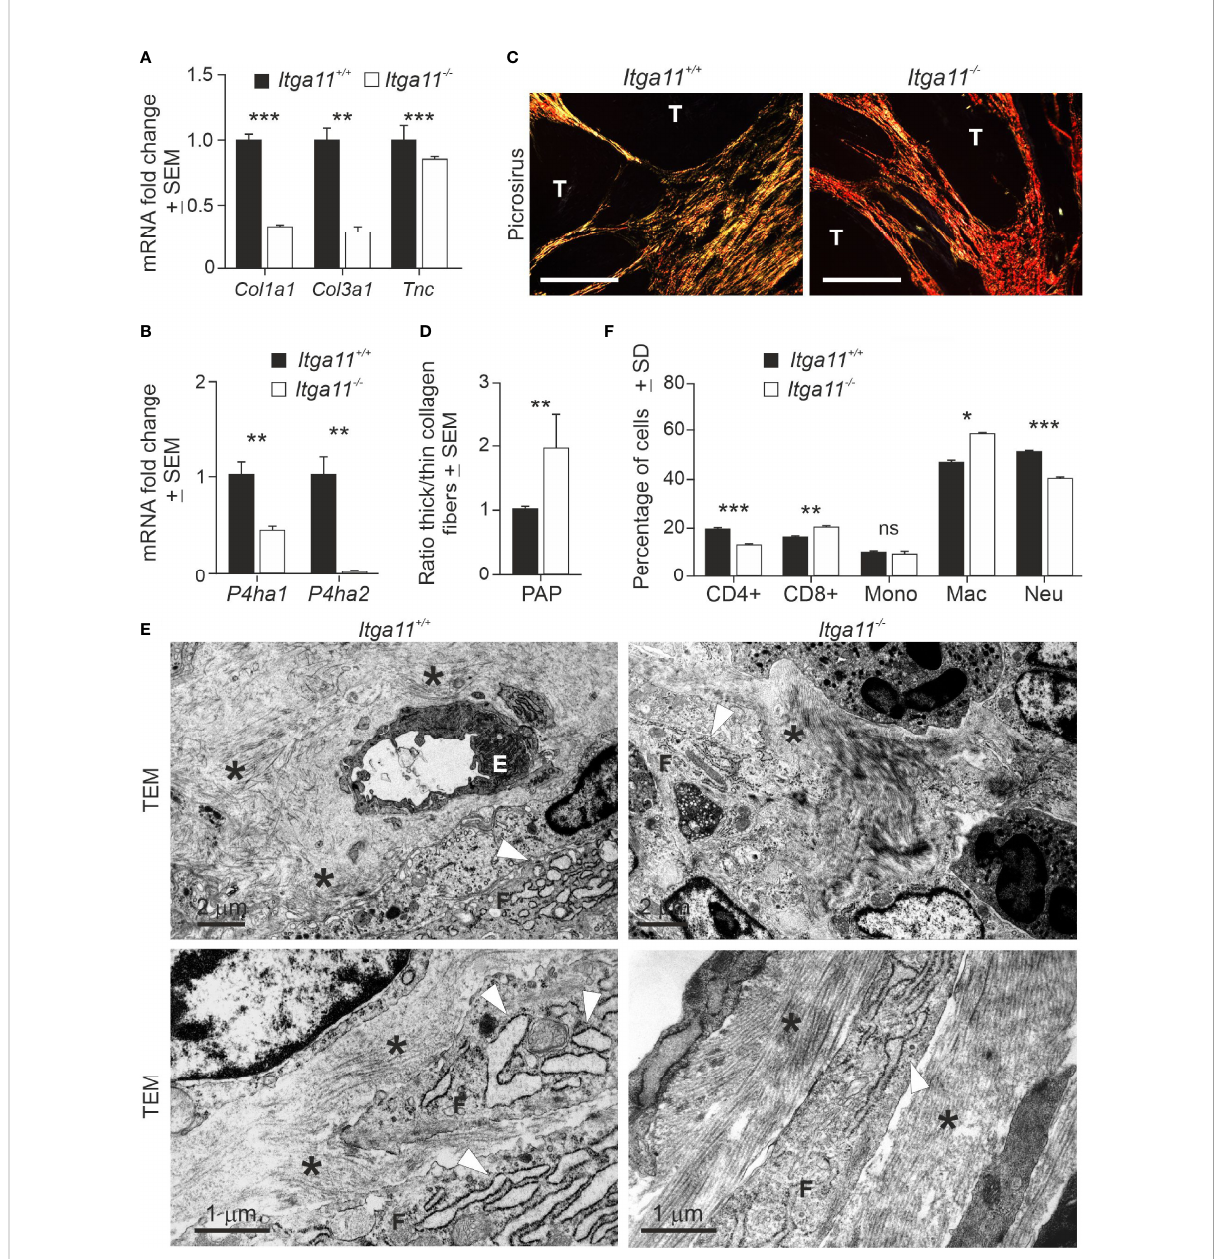
FIGURE 4 Characterization of a 11-de fi cient of skin tumor stroma. (A, B) RT-qPCR analysis of collagen I ( Col1a1 ) and III ( Col3a1 ) a 1 chain, tenascin ( Tnc ), and prolyl-4-hydoxylase 1 ( Pdha1 ) and 2 ( Pdha2 ) in Itga11 +/+ and Itga11 -/- papillomas. RT-qPCR data are an average of ten samples (from different individuals) per genotype collected at weeks 19 – 20 and normalized with endogenous Gapdh . (C) Representative images of picrosirius red staining of Itga11 +/+ and Itga11 -/- papillomas imaged by polarized light microscopy. Thin collagen fi bers appear as yellow/green, and thick collagen bundles appear as red/orange tones. Scale bar, 200 m m. T, tumor. (D) The quanti fi cation of collagen birefringence shows that the ratio of thick/thin collagen fi bers is signi fi cantly increased in the Itga11 -/- tumors compared to the Itga11 +/+ tumors (n = 10 per genotype). (E) Transmission electron microscopy (TEM) of skin tumors (n = 3 per genotype). Representative images of two separate Itga11 +/+ and two Itga11 -/- papillomas with different magni fi cations are shown. In the Itga11 +/+ papillomas, a prominent dilated rough endoplasmic reticulum (rER, arrowhead) of fi broblasts is evident, and collagen fi bers (asterisk) are scattered in the stroma. In the Itga11 -/- tumors, collagen fi bers are organized parallelly in large bundles (asterisk), and the rER is less evident. E, endothelial cell; F, fi broblast; scale bars are marked in the pictures. (F) FACS analysis of immune cells in skin tumors. Ten papillomas per genotype, which were harvested from three individuals, were analyzed. In (A, B, D, F) *, p<0.05; **, p<0.01; ***, p<0.001. ns, not signi fi